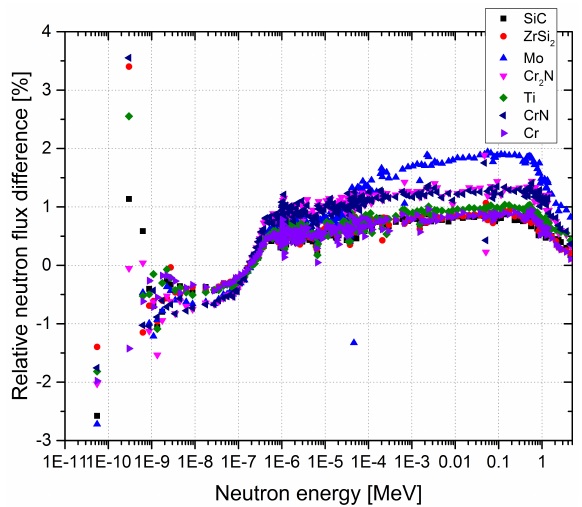
Figure 6. Flux difference between the reference case (cladding without any coating) and claddings with fully dense 15 microns thick coatings.